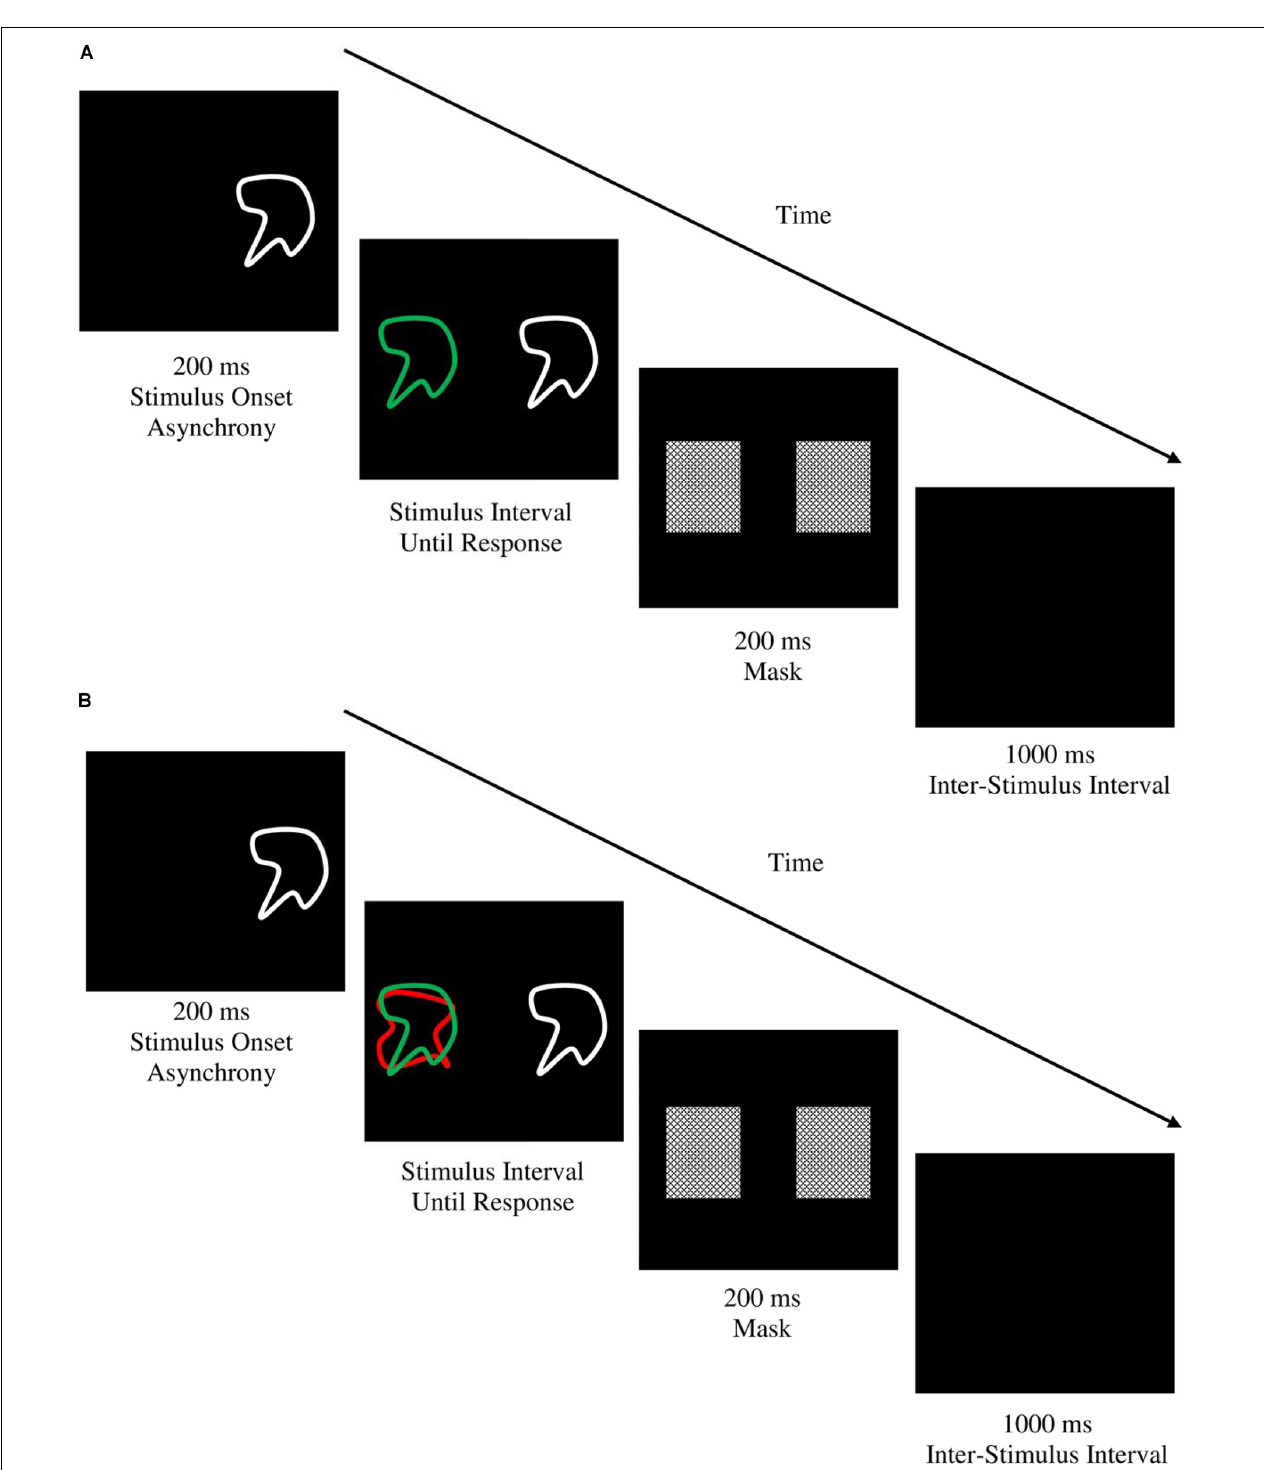
FIGURE 4 | Trial sequence and timing for the (A) control and, (B) distractor conditions of the shape matching task. Each trial began with a 200 ms stimulus onset asynchrony with presentation of the comparison shape preceding the target and distractor stimuli so that participants first attended to the comparison shape before engaging selective attention processes for discriminating the target shape from the distractor, thereby enabling a more reliable measurement of stimulus-stimulus conflict (DeSchepper and Treisman, 1996). Stimuli were displayed until response after which a 200 ms mask was displayed to abolish any afterimages (Friedman and Miyake, 2004). A1000 ms inter-stimulus interval preceded the beginning of the next trial. In both examples above, the target and comparison shape are a match and participants would respond with a right-sided key press indicating